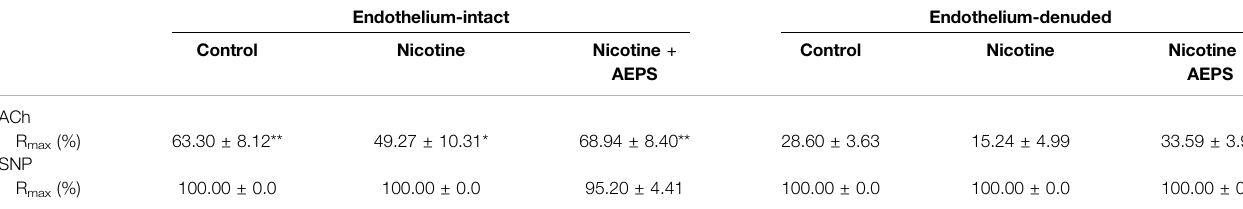
The values are given as mean ± SEM, n (cid:1) 6 – 8 for each group. * p < 0.05, ** p < 0.01 compared with the endothelium-denuded aortic rings from the similar group. ACh, acetylcholine; SNP, sodium nitroprusside; R max , maximum relaxation; AEPS, aqueous extract of Piper sarmentosum Roxb. leaf.